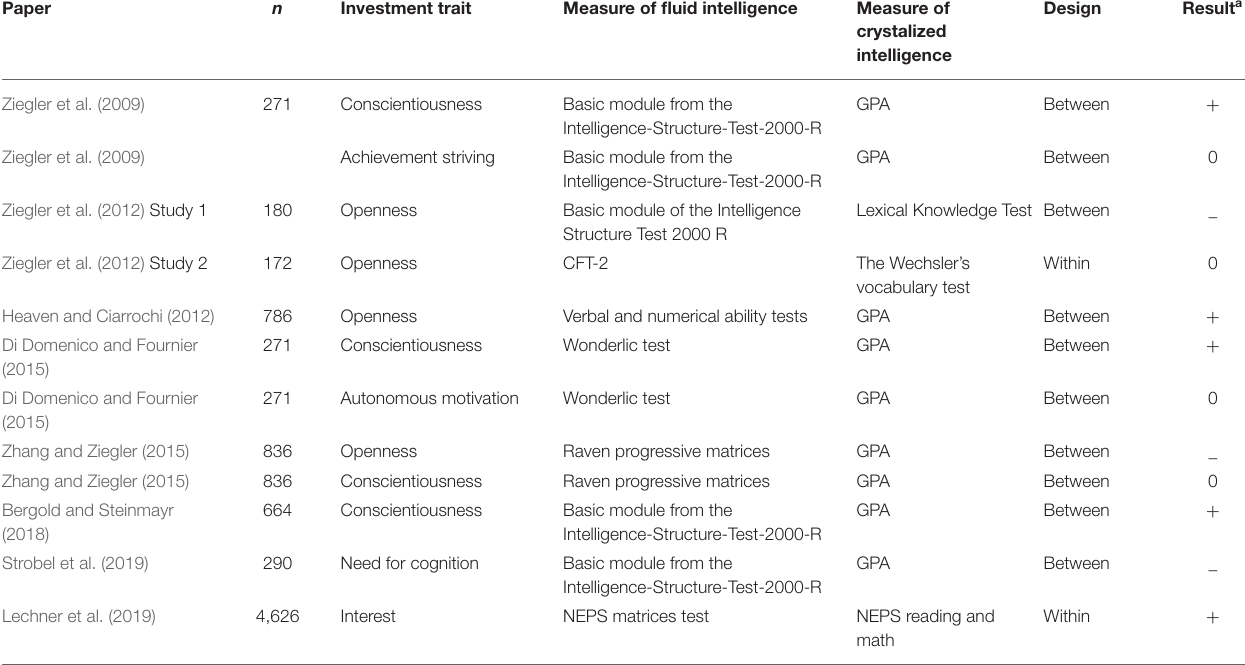
TABLE 1 | Summary of studies examining interactions between investment traits and intelligence tests on crystalized intelligence.